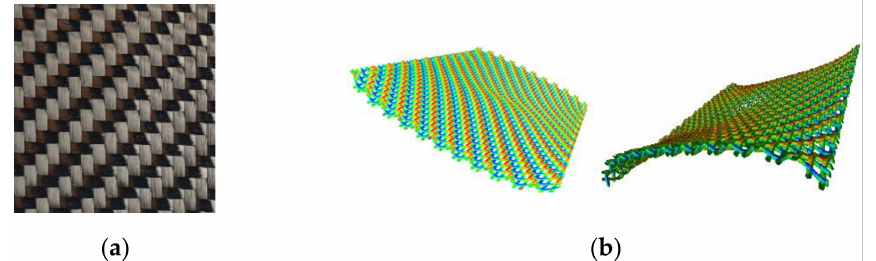
Figure 8. ( a ) Double twill woven fabric; ( b ) folding simulation of the fabric under tension caused by the diagonal pattern and strong contact between yarns.